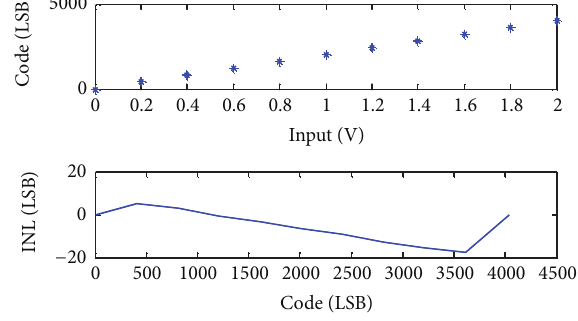
Figure 9: The measured INL of the single slope ADC.